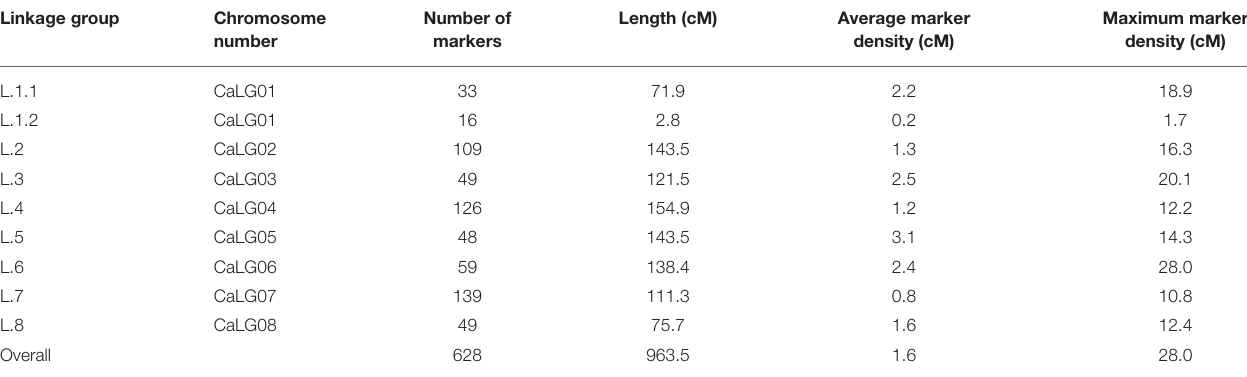
Genotyping wasconducted byDArTseqand628highquality markerswereclustered intoninelinkage groupsand optimally orderedusing theMSTMap algorithmavailable intheASMap package. Each linkage group has a corresponding chromosome number derived from anchoring the genetic map to the chickpea Kabuli reference assembly v.1. Length of each linkage group, average and maximum spacing between markers are indicated using centimorgan (cM) units. A visual illustration of the map can be found in Supplementary Figure 6